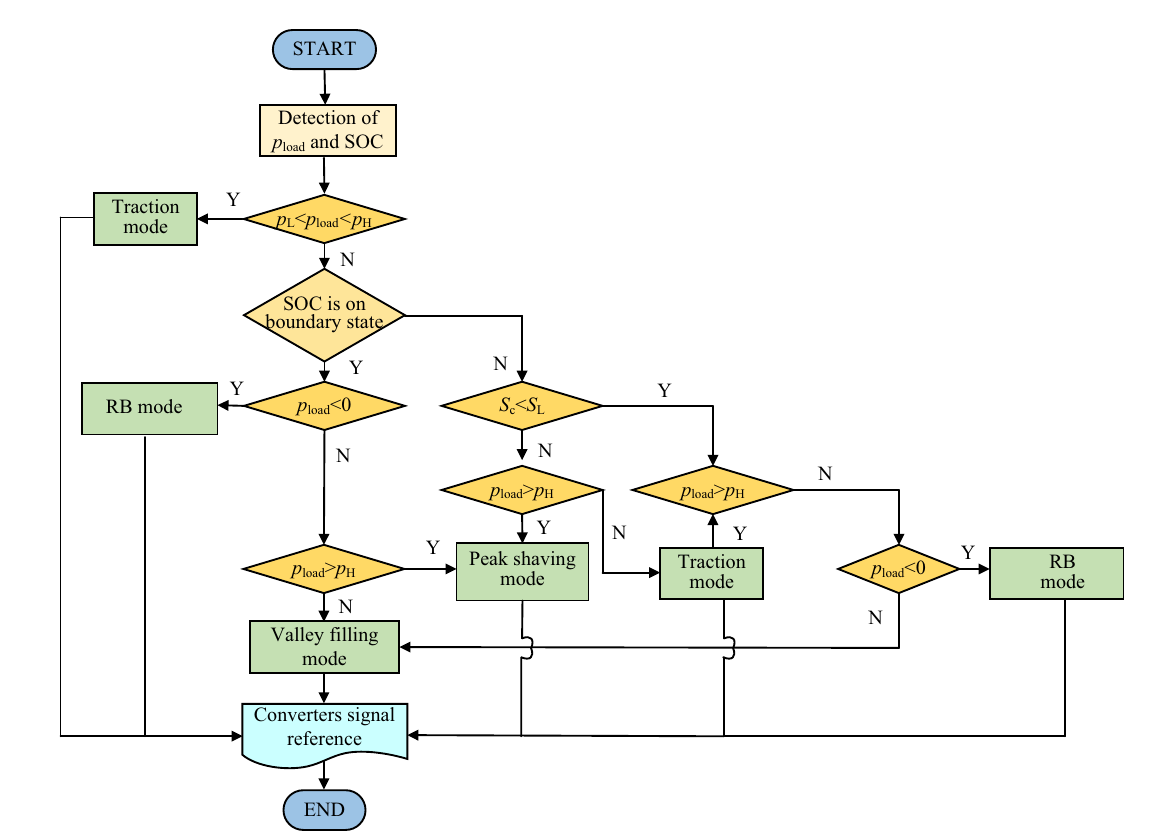
Fig. 5 Upper level control of